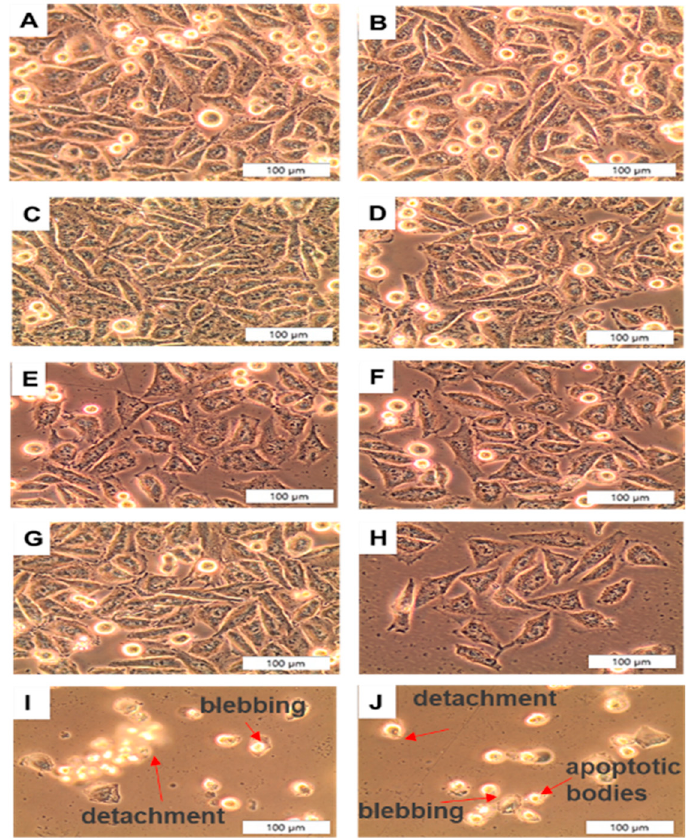
Figure 6. Qualitative morphological analysis post-irradiation of A375 CSCs at 200× magnification: ( A ) CSC only, ( B ) CSC + irradiation, ( C ) CSC + AuNPs, ( D ) CSC + 35 μ m AlPcS 4 Cl, ( E ) A375 + 35 μ M AlPcS 4 Cl-AuNP, ( F ) CSC + 35 μ M AlPcS 4 Cl-AuNP, ( G ) CSC + AuNPs + PDT, ( H ) CSC + 35 μ